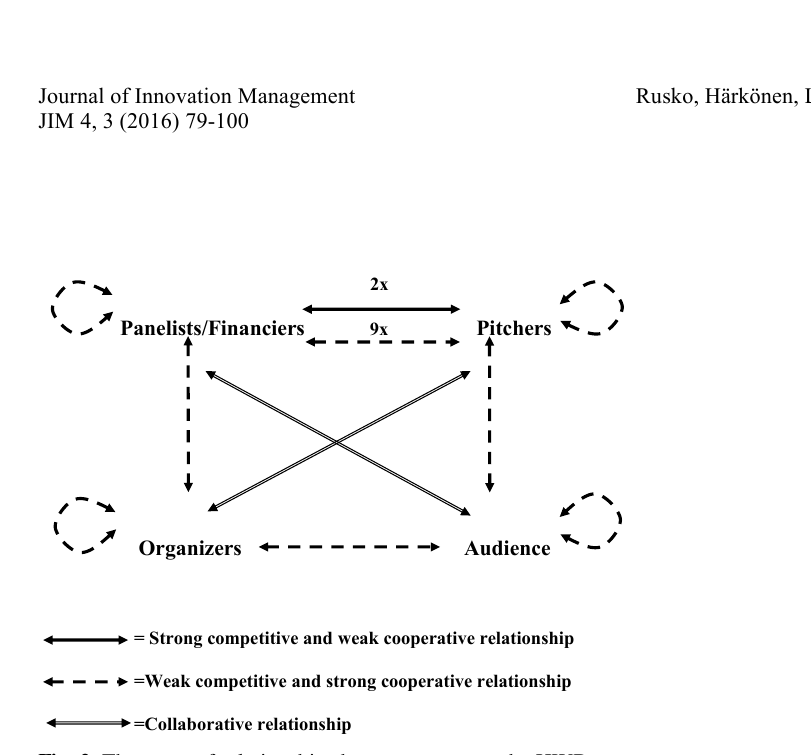
Fig. 2. The types of relationships between actors at the HWB